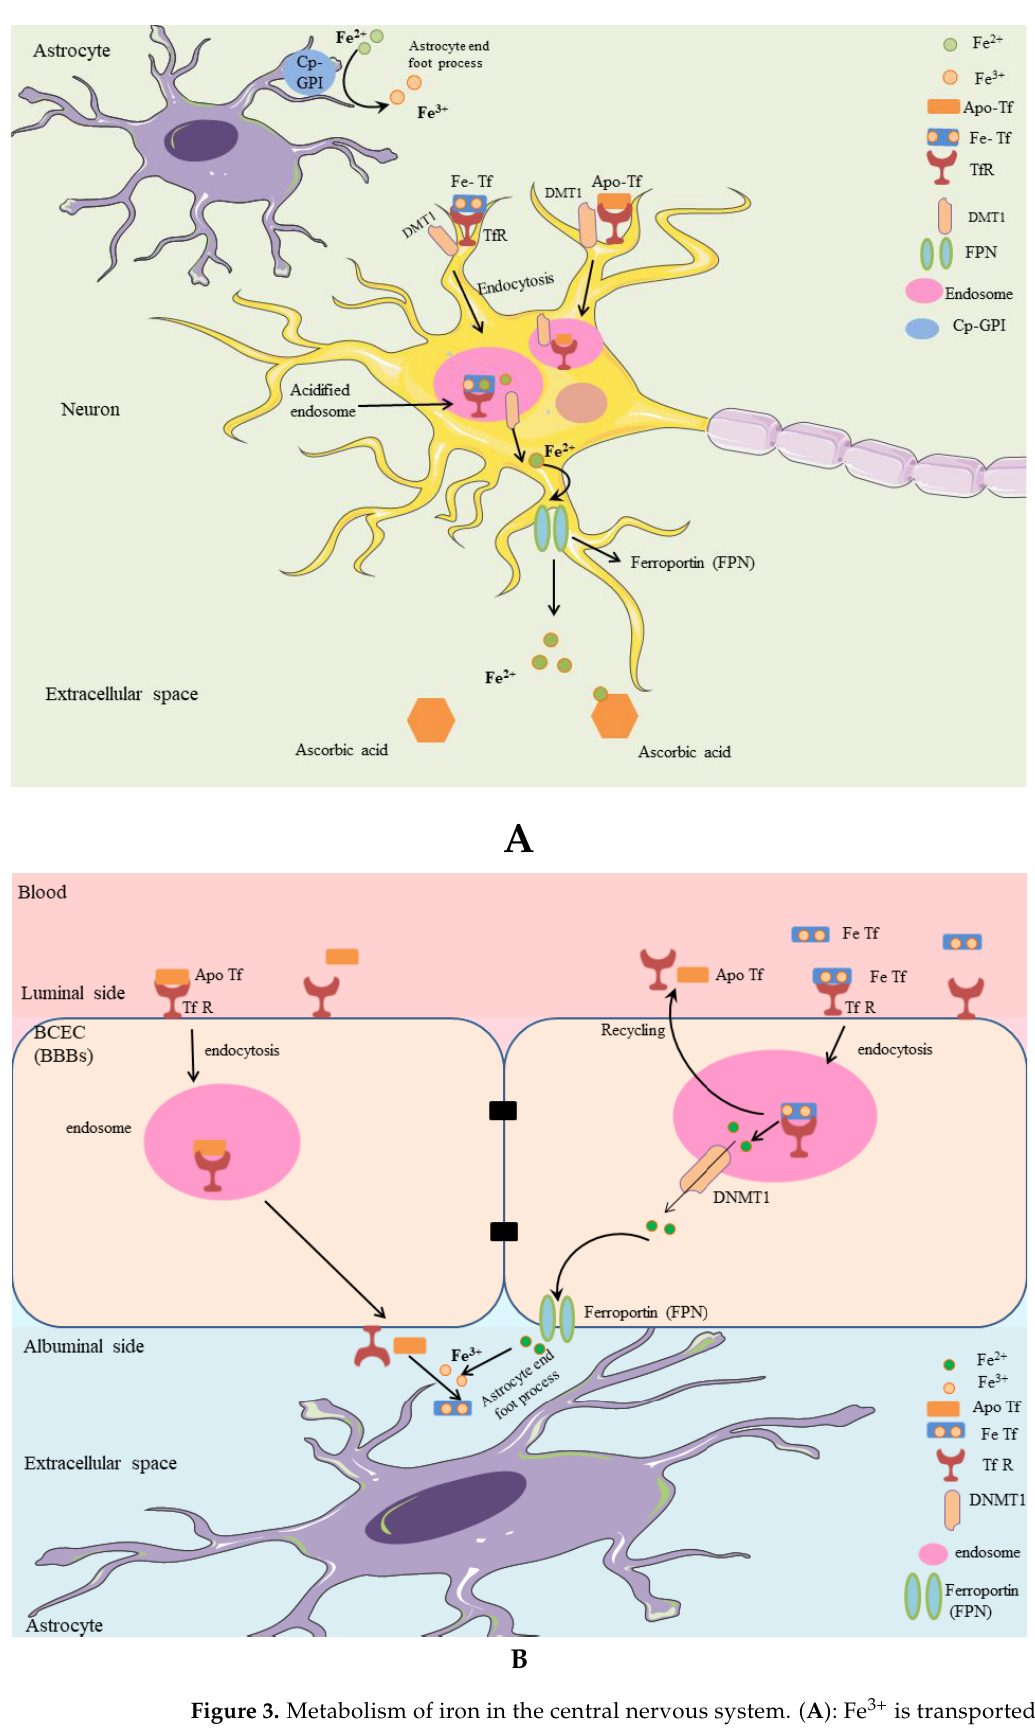
Figure 3. Metabolism of iron in the central nervous system. ( A ): Fe 3+ is transported in the brain ca- pillaries by transferrin. The brain capillary endothelial cells (BCEC) form the Blood-Brain-Barrier (BBB). On the luminal surface of the BCEC, the Transferrin R1 receptor (TfR1) captures the iron- loaded transferrin, and the transferrin/TfR1 is then internalized into an endosome. The endosome moves through the intracellular space and reaches the abluminal side of the BCEC. After that, the endosome fuses with the outer membrane. This exposes Fe 3+ that is released into the interstitial space. Apo-transferrin still binds the TfR1 and undergoes endocytosis again to return to the luminal side BCEC. At this point, the apo-Tf is released. ( B ): The complex of Fe 3+ transferrin travels through the extracellular space and reaches a neuron. The TfR1 on the neuron surface begin the endocytosis. Neuronal membrane exhibits DMT1 at difference from the BCEC. This wraps around the endosome and enters with it. Presynaptic vesicles bear ferroportin (not shown), suggesting that Fe 2+ can travel via the synaptic vesicles to the inter-synaptic space, where Fe 2+ is released after vesicle fusion. Thus, there is free iron in the pre- and postsynaptic cleft. On the outside of the tip of astrocytes, Glyco- sylphosphatidylinositol (GPI)-anchored ceruloplasmin (Cp-GPI) facilitates the oxidation of Fe 2+ to Fe 3+ , allowing iron uploading into apo-transferrin. The intracellular and extracellular mechanisms can work synergistically to transfer iron to the neuronal cells. Iron seems to enter the brain in this way, mostly. However, experiments on hypo- transferrinemic mice have demonstrated that iron can travel to the brain also via a Trans- ferrin-independent mechanism [52]. For details on this mechanism, see Mills and col- leagues [53]. The BCEC luminal side is in contact with the astrocytes and does not appear to be directly connected with neurons. In the space between the astrocyte and BCEC, Fe 3+ can bind apo-transferrin or ATP and citrate, as well as other low-weight elements. These com- plexes are present everywhere in the extracellular space of the brain, but they appear mainly concentrated in the space between the astrocyte and the BCEC side.